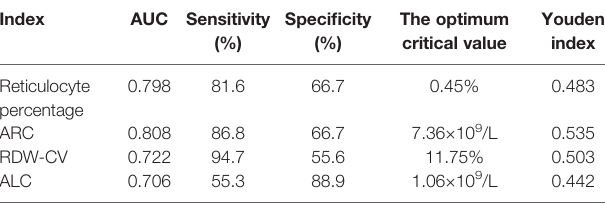
ROC, receiver operating characteristic; AUC, area under a curve; ARC, absolute reticulocyte count; RDW-CV, red cell distribution width - coef fi cient of variation; ALC, absolute lymphocyte